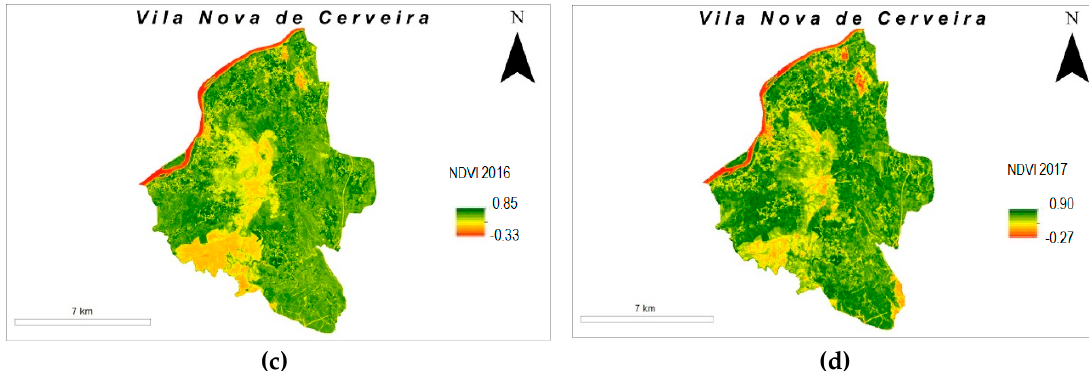
Figure 4. NDVI maps of Arouca for: ( a ) prefire and ( b ) postfire; and V. N. Cerveira for ( c ) prefire and ( d ) postfire derived from Landsat 8 data (adapted from [44]).